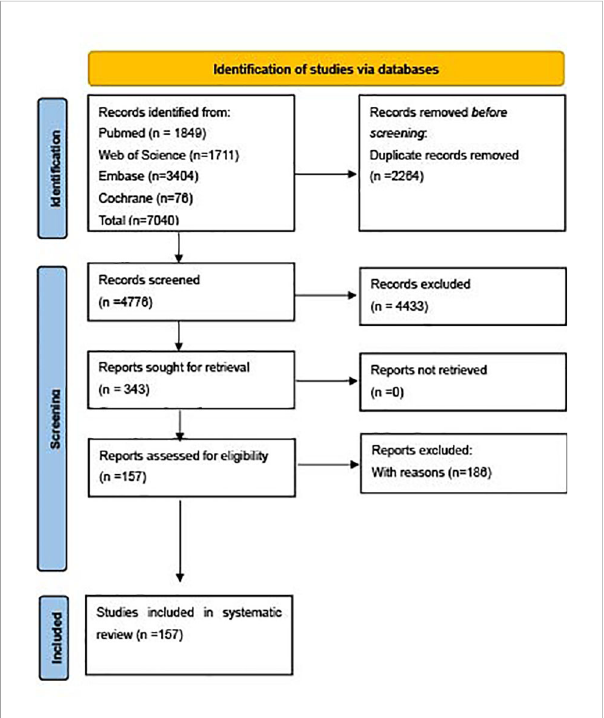
FIGURE 1 Flow of diagram of meta-analysis generated by